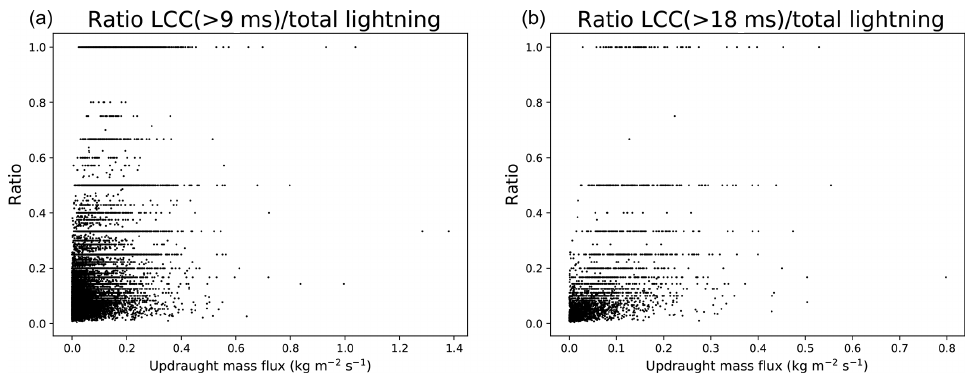
Figure 2. Ratios of (a) LCC( > 9ms) and (b) LCC( > 18ms) lightning to total lightning flashes versus the updraft mass flux extracted from